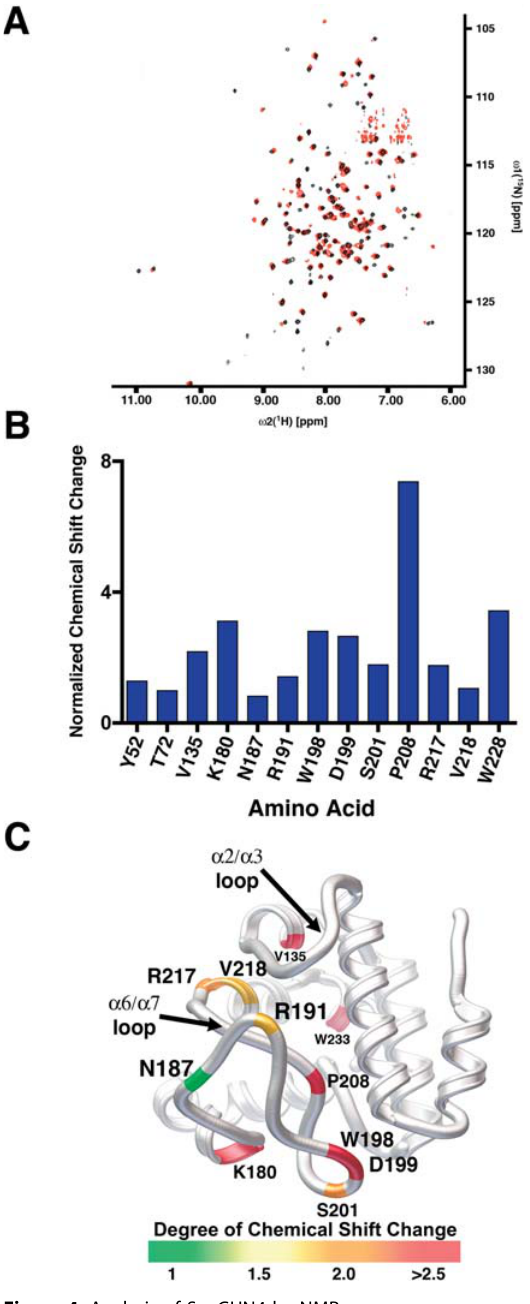
Figure 4. Analysis of SynGUN4 by NMR (A) Comparison of spectra obtained from 1 H- 15 N TROSY experi- ments of SynGUN4 in the absence (black) and presence (red) of 2 mM deuteroporphyrin. (B) Normalized chemical shifts for those 1 H- 15 N cross peaks whose positions change in the presence of 2 mM deuteroporphyrin. In general, the largest shifts cluster for residues on the a 6/ a 7 loop. The remaining positions with significant chemical shifts reside on the ‘‘ greasy palm ’’ region of SynGUN4. (C) Rendered ribbon diagram of the Gun4 core domain with the position of the shifting 1 H- 15 N cross peaks mapped onto the backbone structure of SynGUN4. The magnitude of the chemical shift changes shown corresponds to the color bar at the bottom. Briefly, shifts larger than 2.5 parts per million (ppm) are shown in red, shifts between 2 and 2.5 ppm are shown in orange, shifts between 1.5 and 2 ppm are shown in yellow, and shifts of 1.5 ppm and less are shown in green. DOI: 10.1371/journal.pbio.0030151.g004 PLoS Biology |